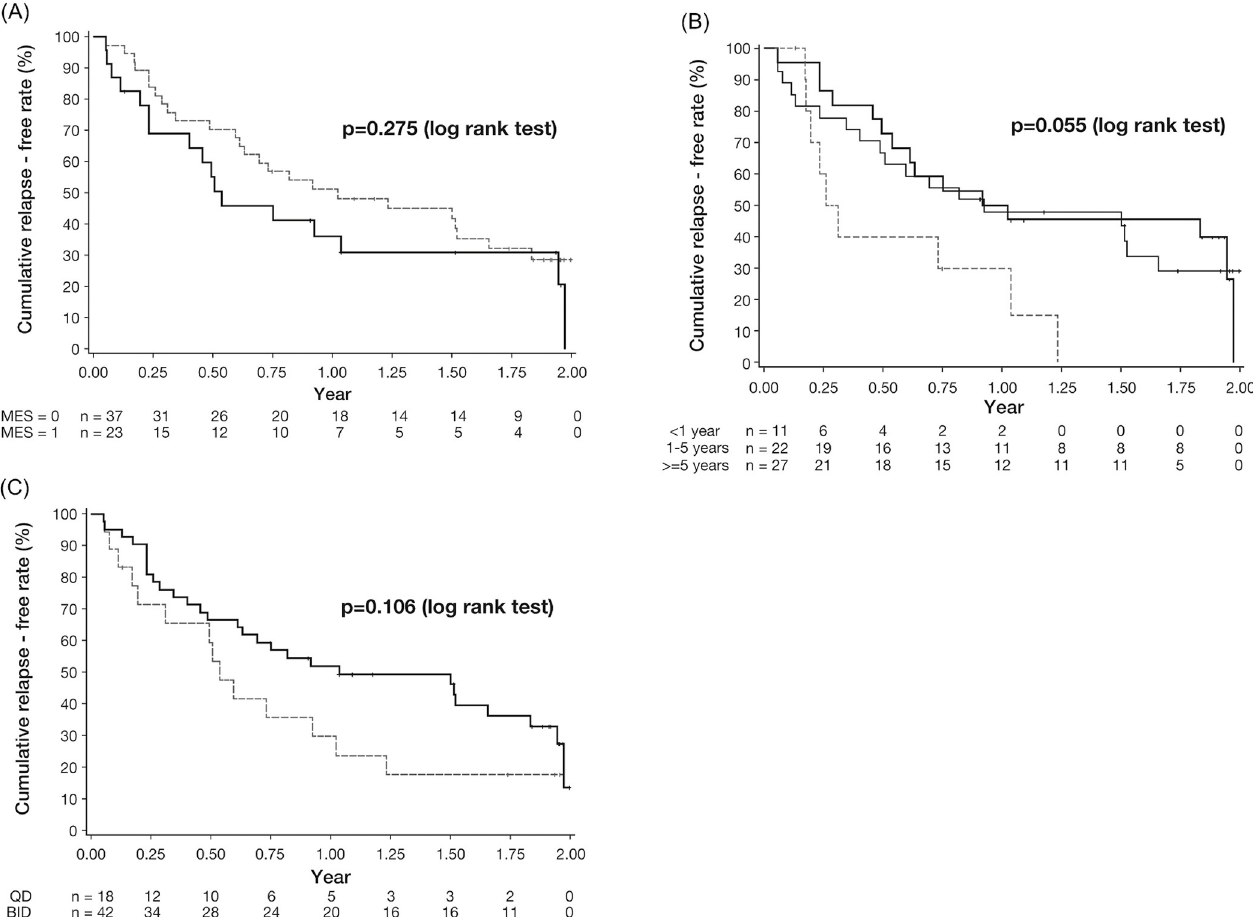
Fig 4. Kaplan–Meier plot for the relapse in patients with ulcerative colitis who achieved clinical remission and mucosal healing by treatment with budesonide foam in phase 2 or phase 3 clinical trials in Japan by a covariate. (A) endoscopic subscore: MES = 0 (broken line) and MES = 1 (solid line) at start of this study, each median survival time (year) was 1.02 (95% CI: 0.61 to 1.66) and 0.54 (95% CI: 0.23 to 1.95), respectively. There was no significant difference between the groups (log-rank test, P = 0.275). (B) The disease duration: duration of < 1 year(broken line), duration of 1–5 years (solid line), duration of � 5 years (thin solid line). Each median survival times (year) were 0.28 (95% CI: 0.17 to 1.03), 0.97 (95% CI: 0.49 to 1.97), 0.93 (95% CI: 0.40 to 1.66), respectively. There was no significant difference between Group 1, 2 and 3 (log-rank test, P = 0.055). (C) Patients receiving budesonide foam, QD (broken line) and BID (solid line), each median survival times (year) were 0.54 (95% CI: 0.19 to 1.02) and 1.03 (95% CI: 0.61 to 1.83), respectively. There was no significant difference between Group 1 and Group 2 (log-rank test, P = 0.106).